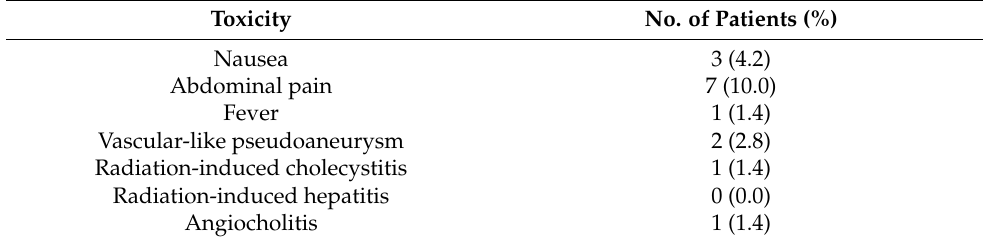
Table 4. Clinical toxicities of transarterial radioembolization